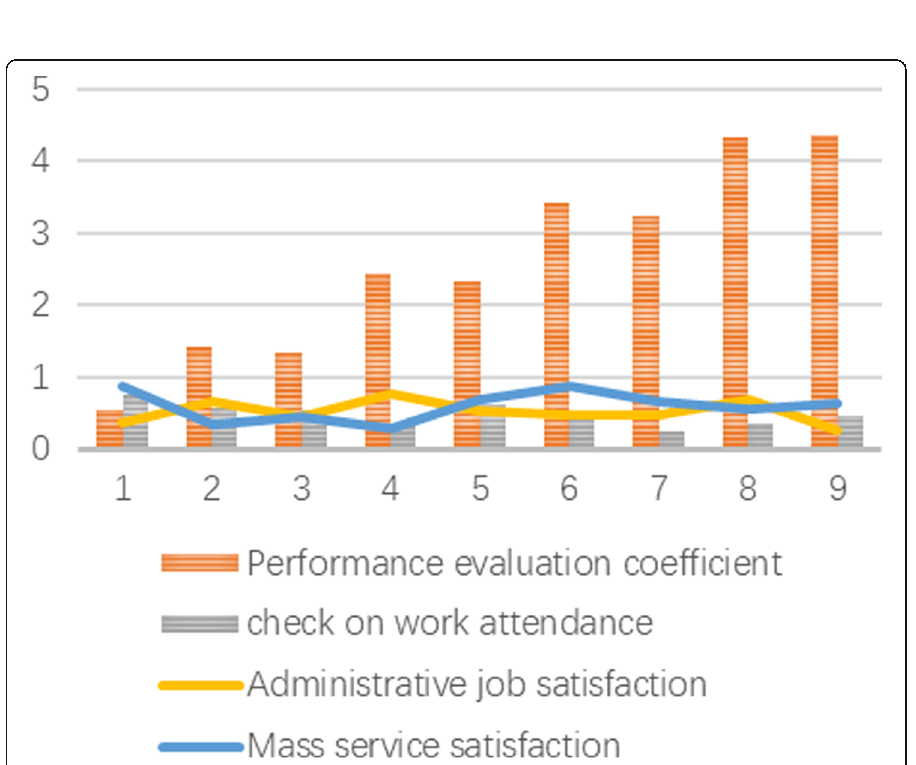
Fig. 4 Results of statistical analysis of performance evaluation of government